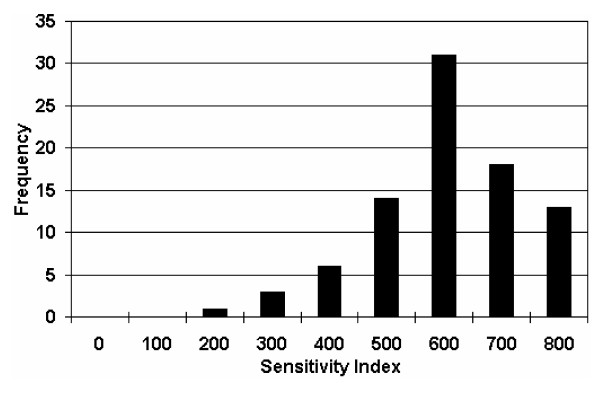
Frequency histogram showing heterogeneity of the IndexSUM for gefitinib alone in all tumours tested (n = 86).